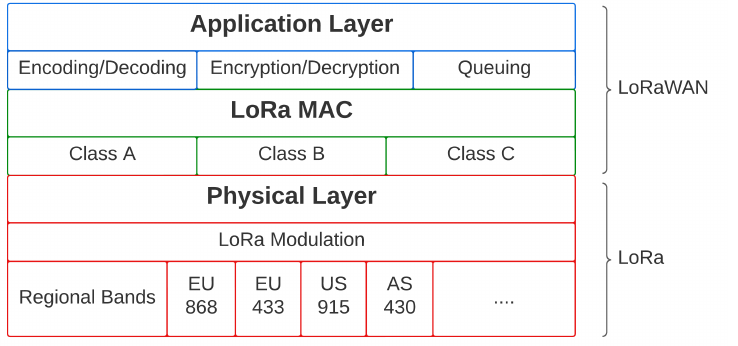
Figure 2. LoRaWAN protocol